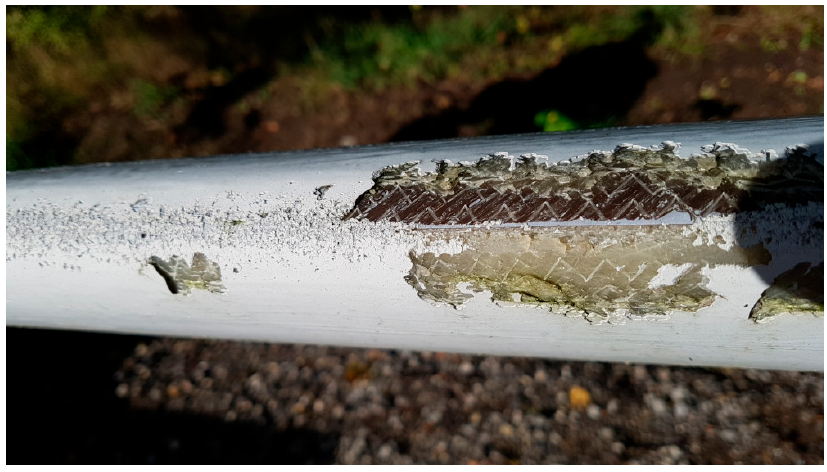
Figure 3. Eroded blade and mechanism of blade erosion (photo Jakob I. Bech).